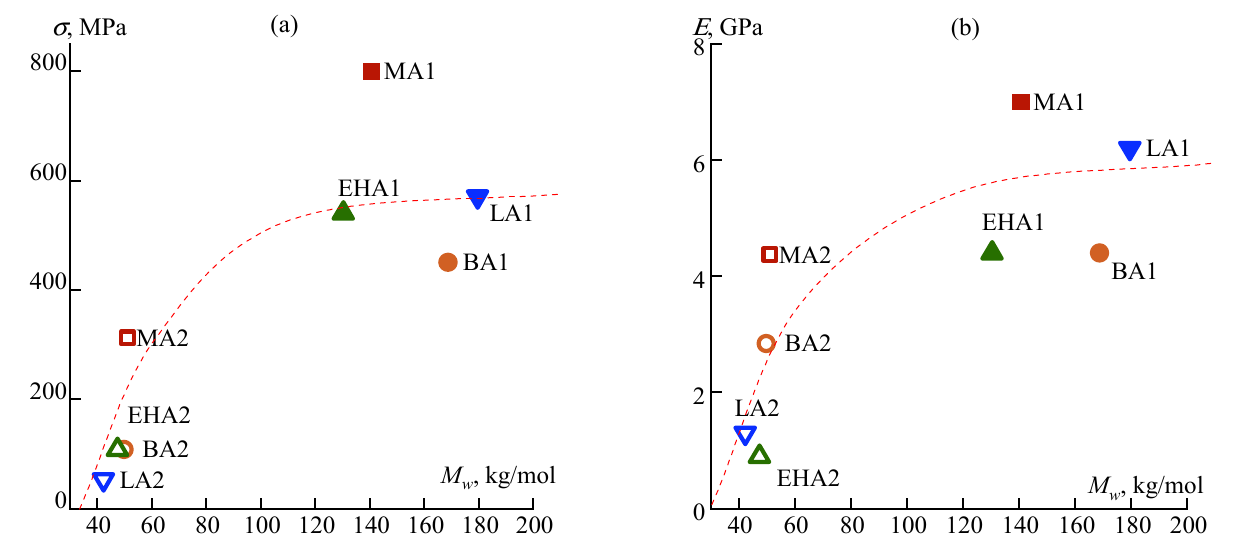
Figure 10. Correlation of strength ( a ) and elastic modulus ( b ) of fiber with a molecular weight of copolymers. The dotted line shows the expected saturation curves corresponding to the stabilization of the polymer properties.